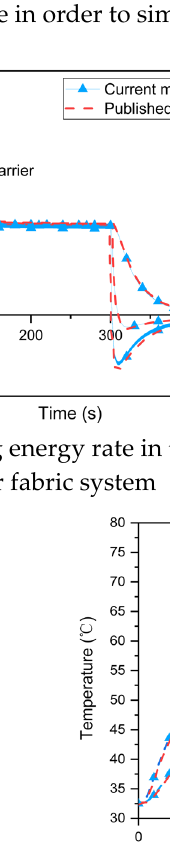
( b ) Space step Figure 4. Simulation results of the grid independence study. 3. Results and Discussion 3.1. Model Validation To validate the heat transfer model, parameters such as instantaneous heat flux, skin temperature and time to skin burns in single–layer and multi–layer fabric systems with microenvironments under different radiative heat exposures were predicted by the cur-